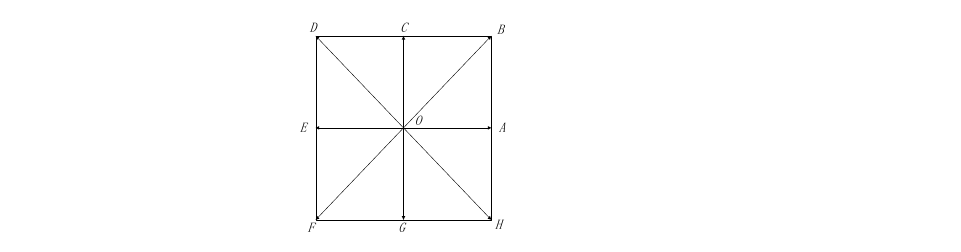
Fig. 3. Points E, O and A locate on the boundary of the image; B,C and D locate inside the image while F, G and H outside the image.